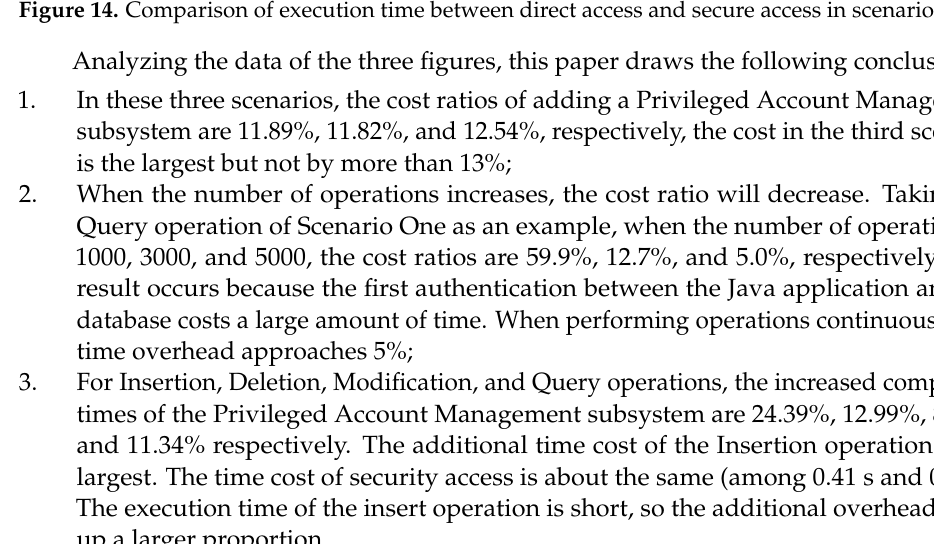
Figure 14. Comparison of execution time between direct access and secure access in scenario